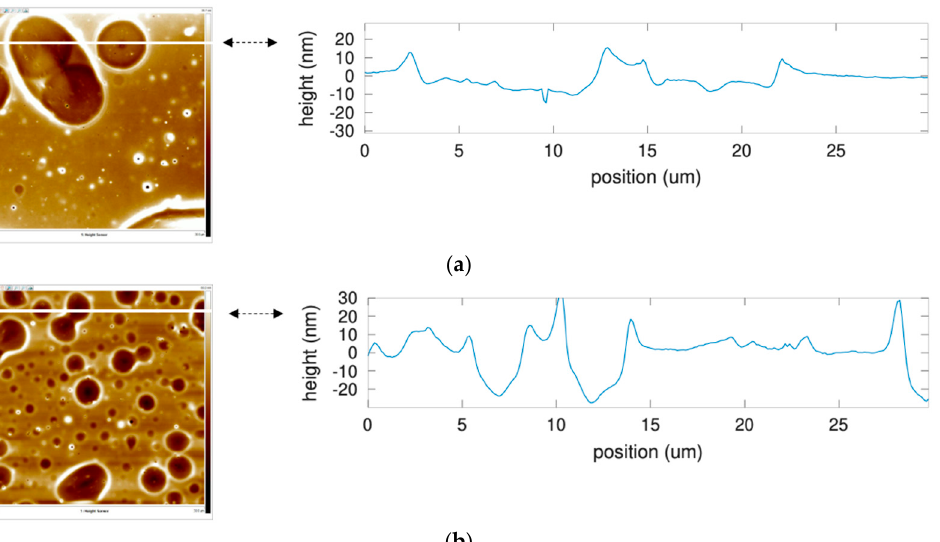
Figure 9. AFM topographies (left) and corresponding height profile along the white line (right) of a silicon surface covered with a spin-coated layer of PBMA (thickness: 500 nm) after immersion ( a ) in aqueous solution at pH = 5.0 for 12 h and ( b ) in water-acetonitrile (98:2) solution at pH = 5.0 for 12 h. The PBMA layer exhibits some holes with a depth of 20 nm and 50 nm in ( a , b ), respectively.